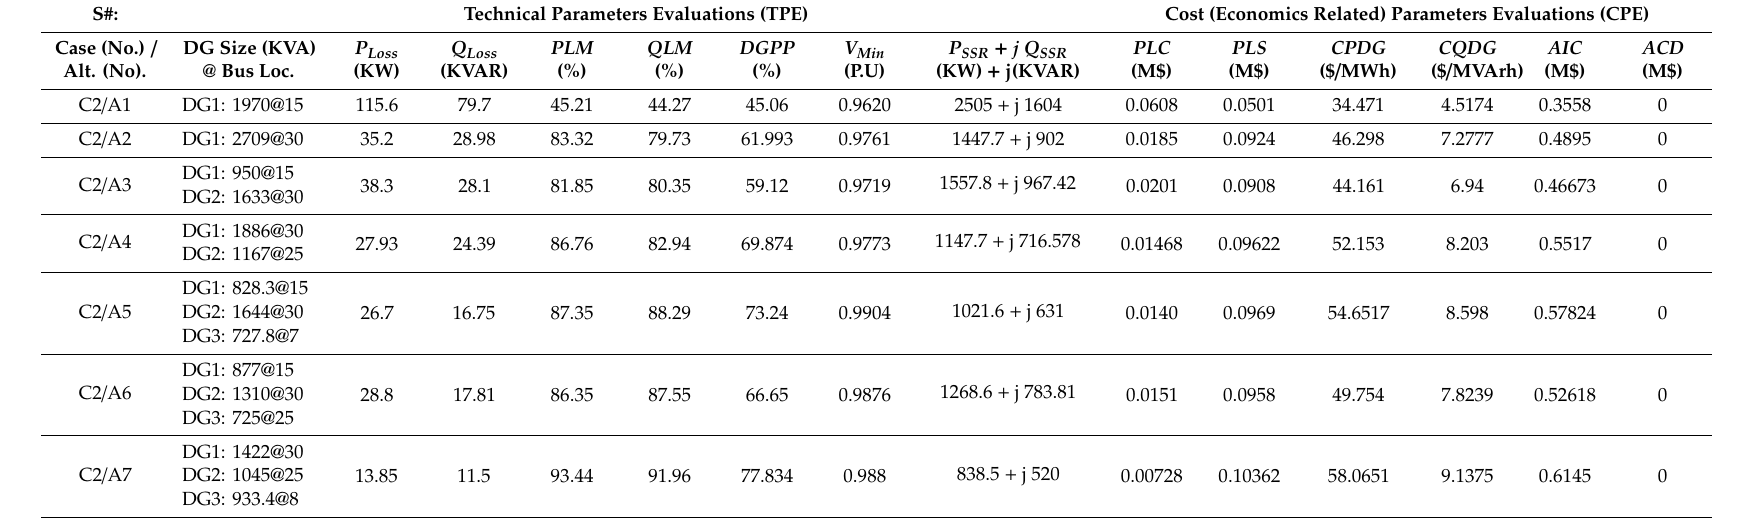
Table 7. Techno-economic evaluation analysis in case 2 (C2_NL) for 33-bus MDN.